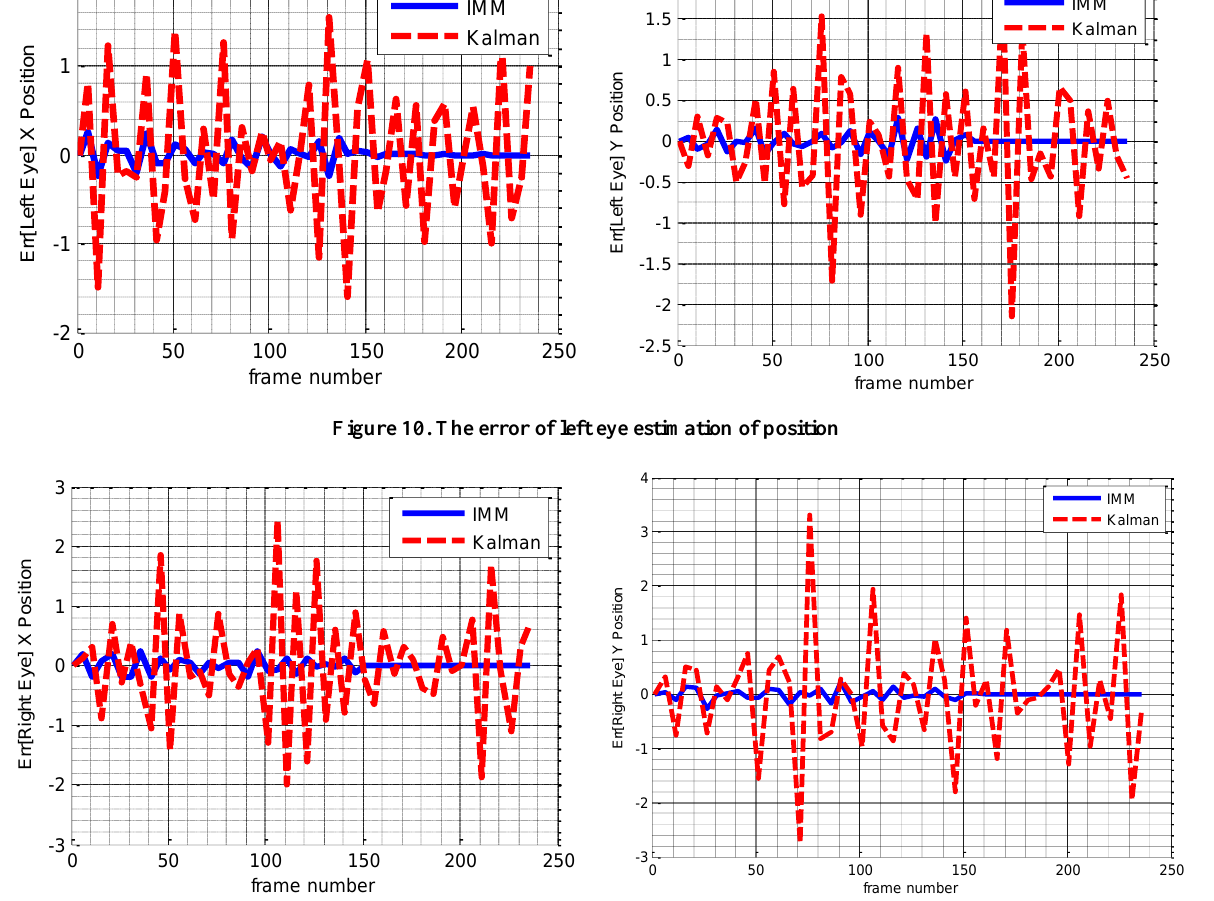
Figure 11. The error of right eye estimation of position